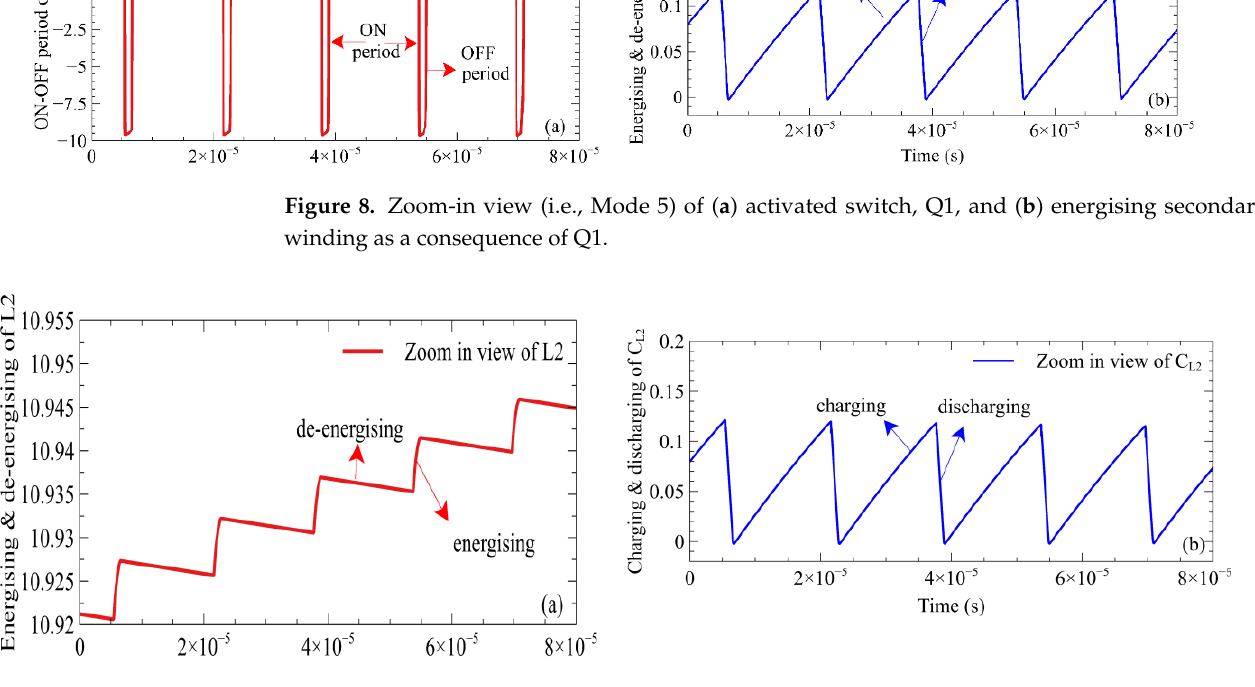
Figure 9. Energising and charging processes (i.e., Mode 6). ( a ) Zoom-in view of L2 and ( b ) charging process of load capacitor, C L2 .